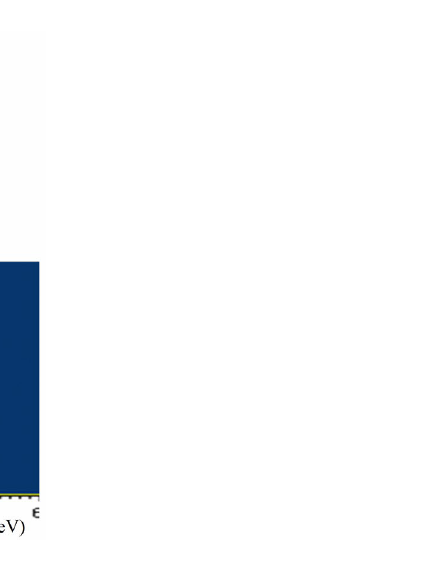
Figure 6. The EDX spectra of In 2 S 3 thin film at 550 °C and 100